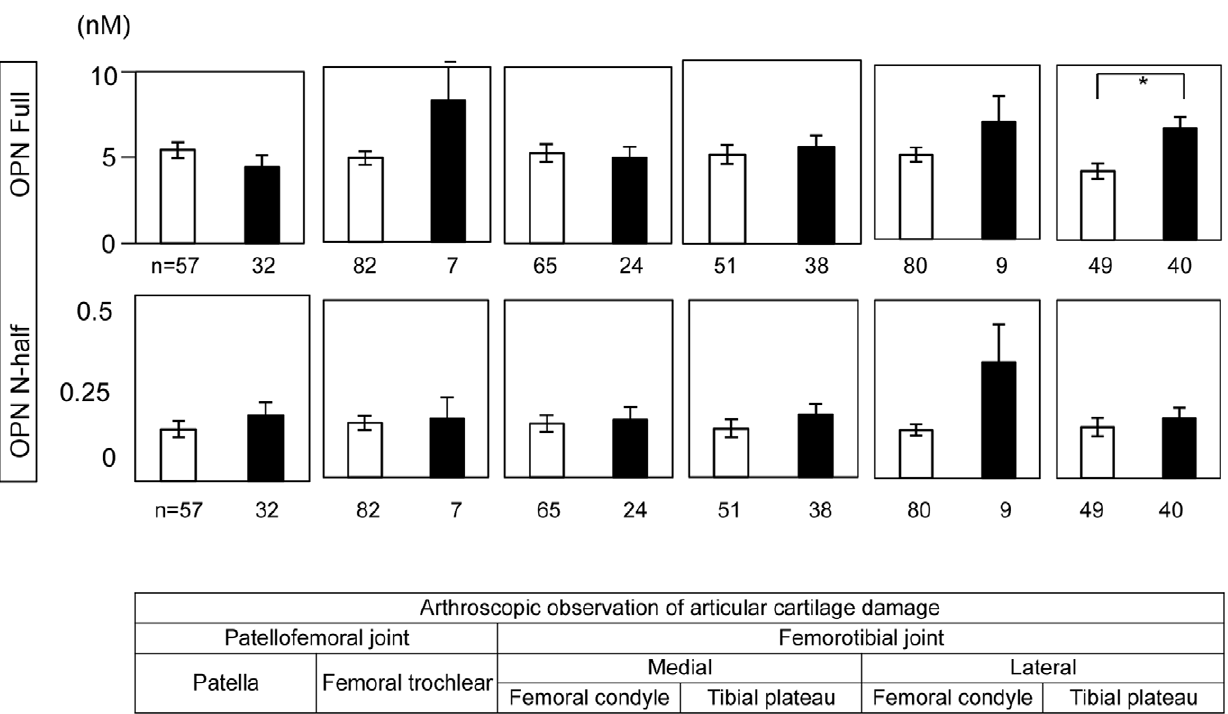
Figure 2. OPN Full levels in synovial fluid are positively correlated with joint damage in lateral tibial plateau. Severity of articular cartilage damage was scored according to the protocol described by Asano et al [32] with minor modification (Table S1). Open bar; intact articular cartilage (score=1) Closed bar; damaged articular cartilage (score=2 , 6). Number of samples is indicated below each column. Data are indicated mean + / 2 SEM. *; p ,